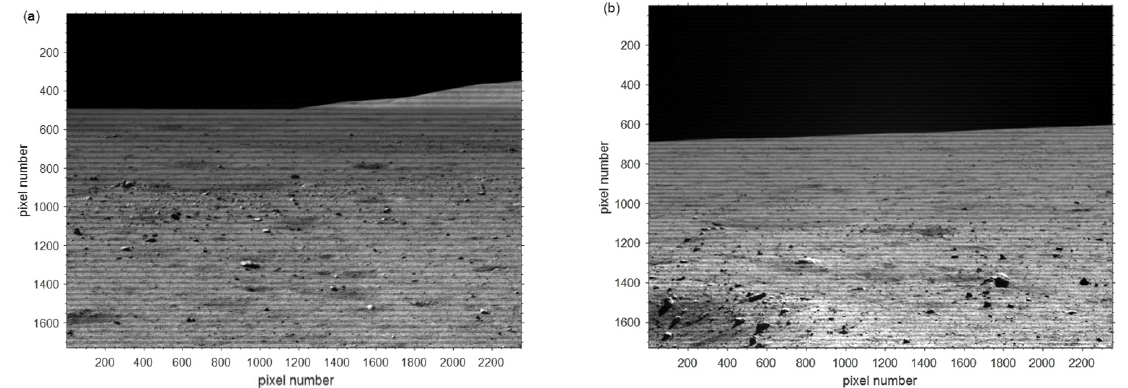
Figure 7. ( a , b ) demonstrate the landscape near the CE-5 landing site, taken by the PCAM onboard Figure 7. ( a ) and ( b ) demonstrate the landscape near the CE-5 landing site, taken by the PCAM the CE-5 onboard the CE-5 lander.